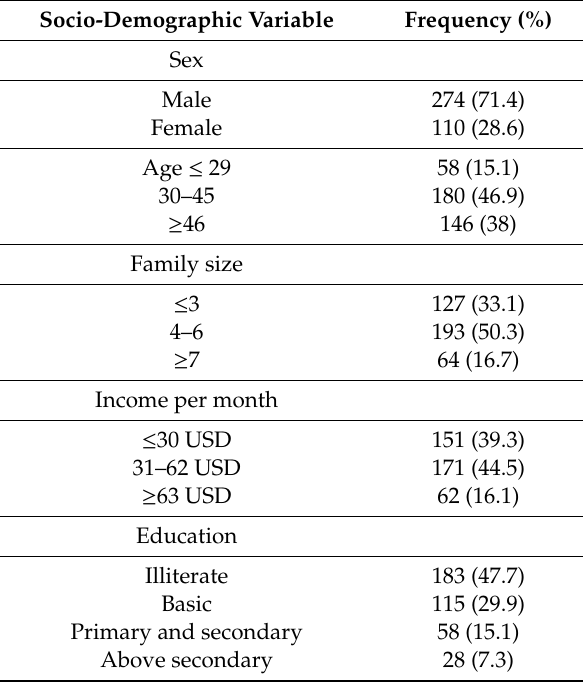
Table 1. Socio-demographic characteristics of the study participants (N = 384),